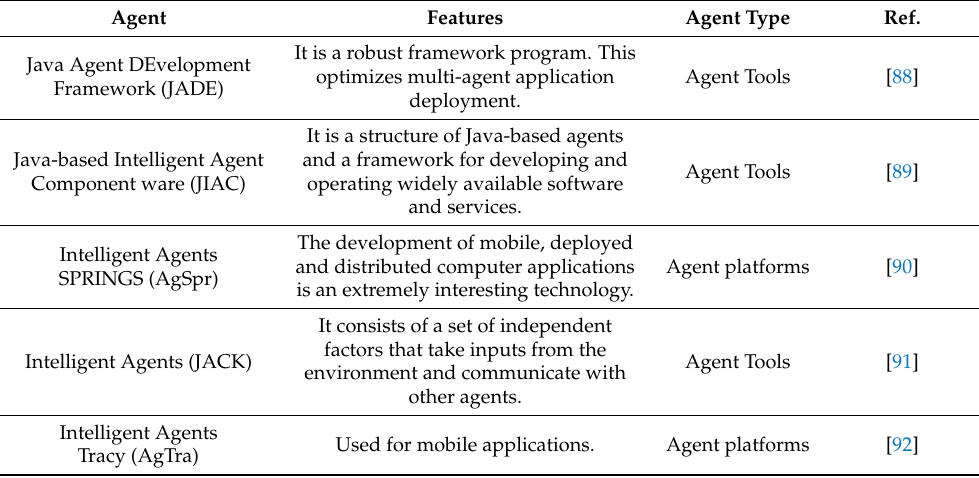
Table 3. Intelligent AGENTS’